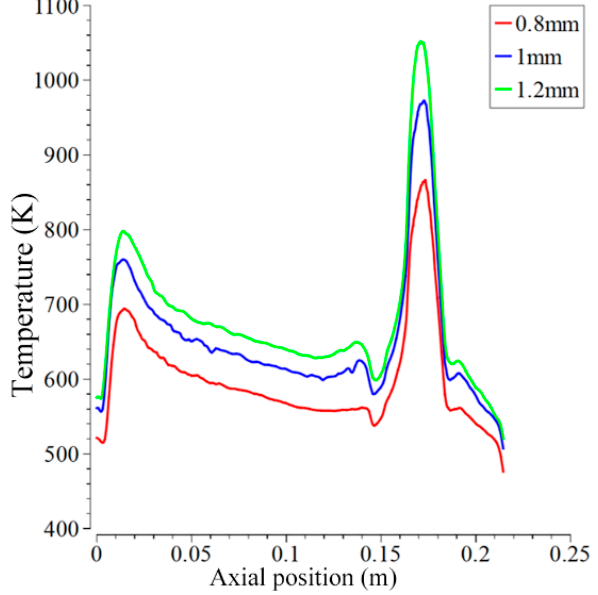
Figure 24. Wall temperature curves under different inner wall thickness conditions.